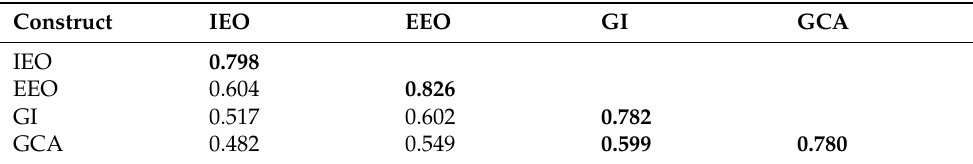
Table 3. Discriminant validity.